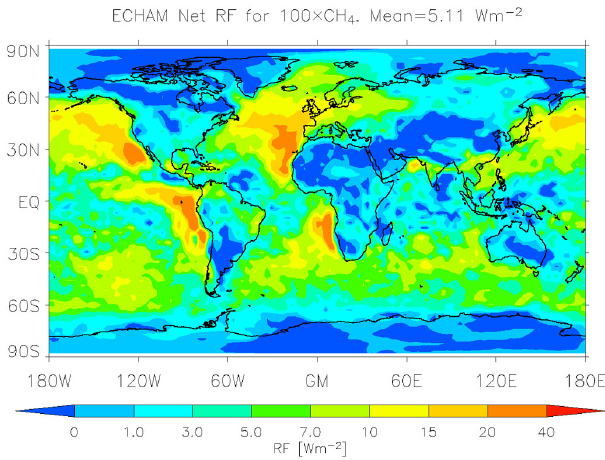
Fig. 4. Predicted percentage decrease in cloud droplet number con- centration (CDNC) when the CH 4 concentration is increased by a factor of 100, using